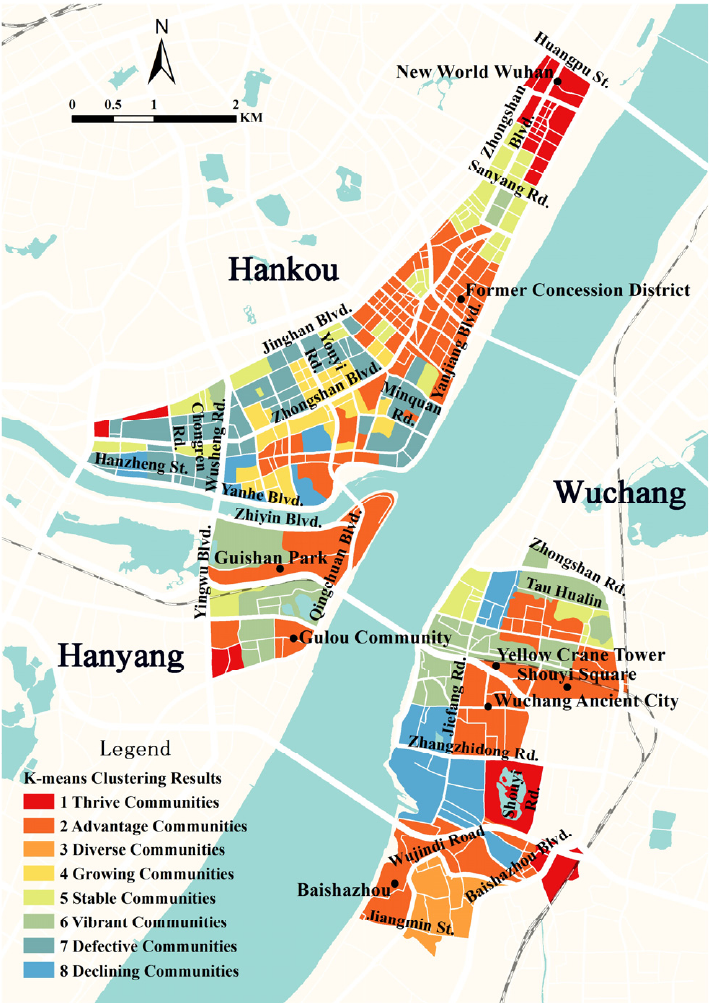
Figure 4. K-means clustering results.